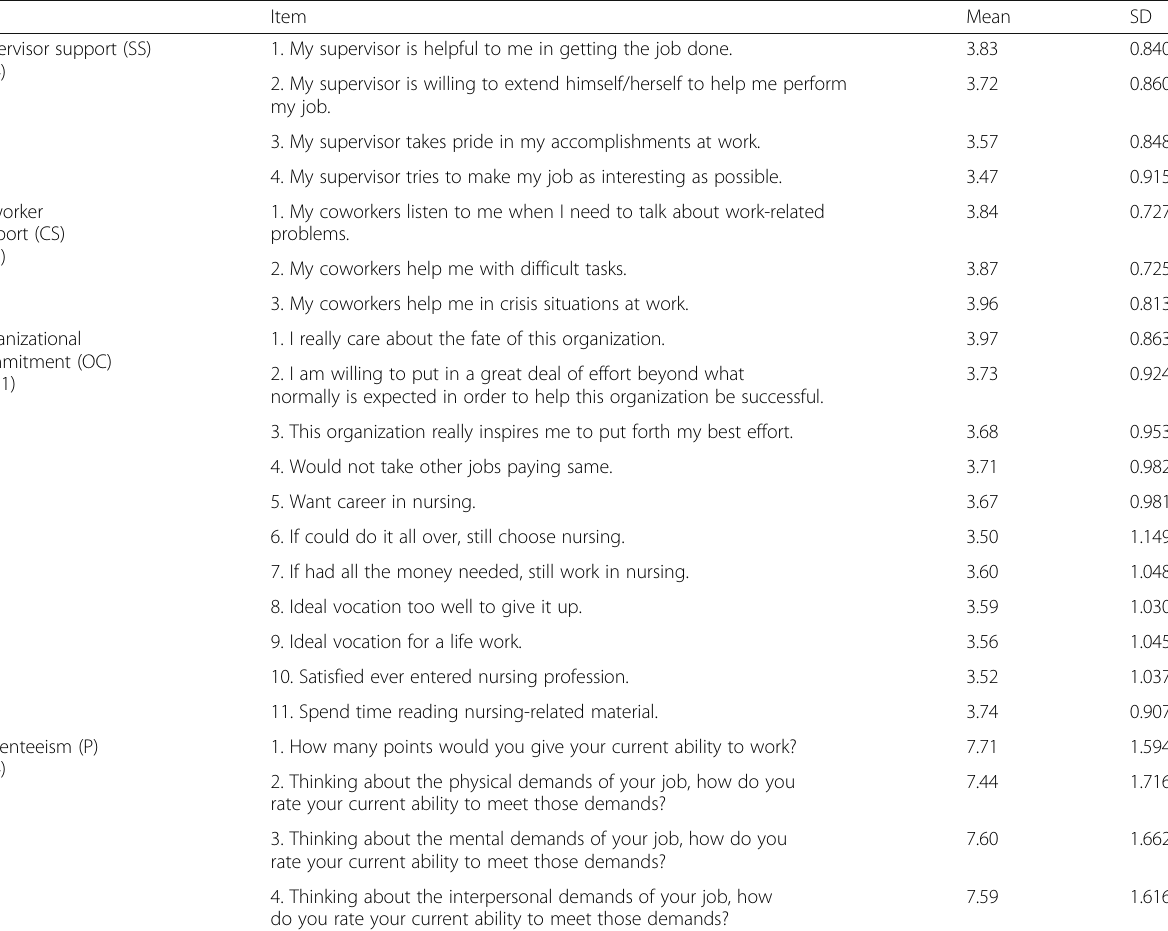
Table 2 Mean and standard deviation (SD) for items related to supervisor support, coworker support, organizational commitment, and presenteeism